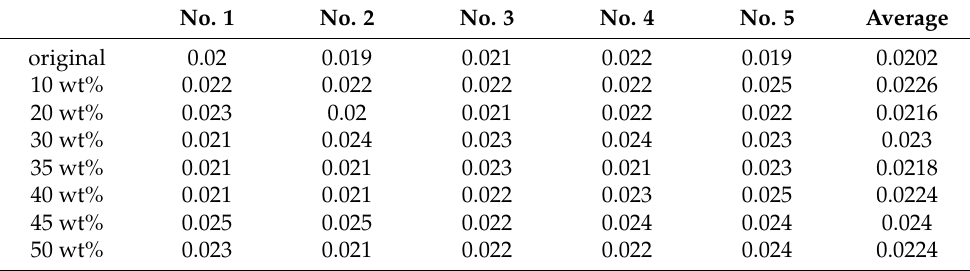
Table 2. Each concentration of Co 2+ /Al 2 O 3 takes the weight of 10 particles.